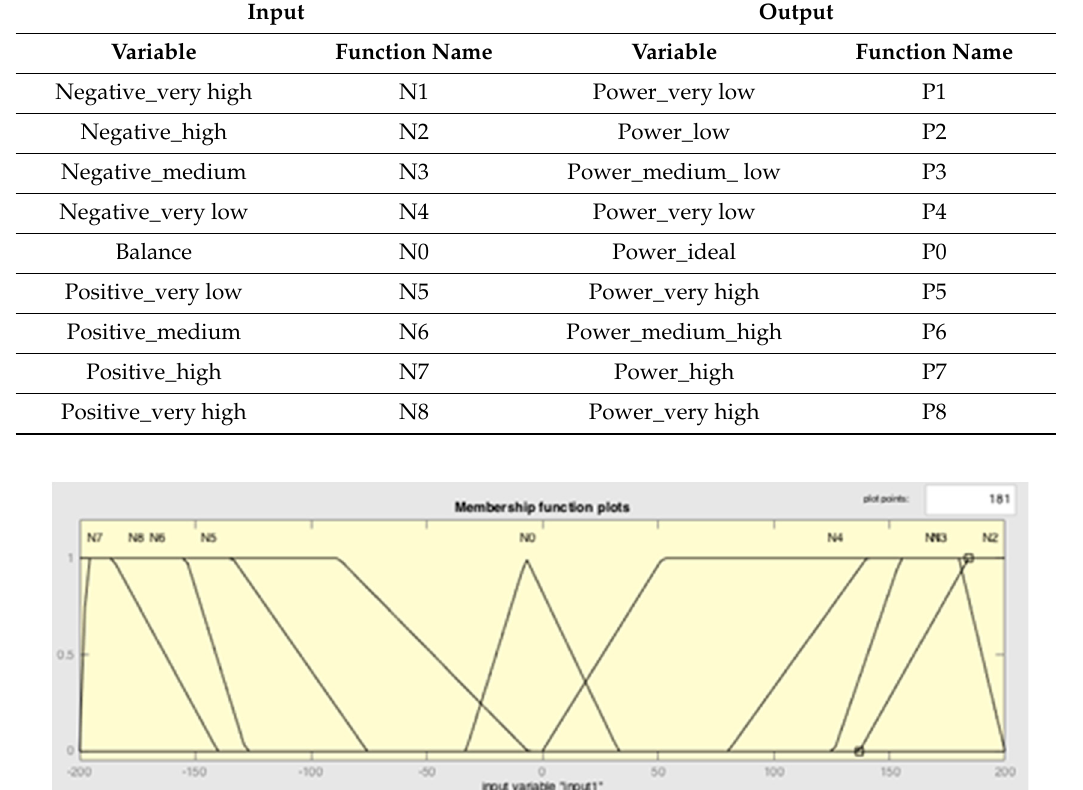
Table A2. Input and output functions with fuzzy system rules.